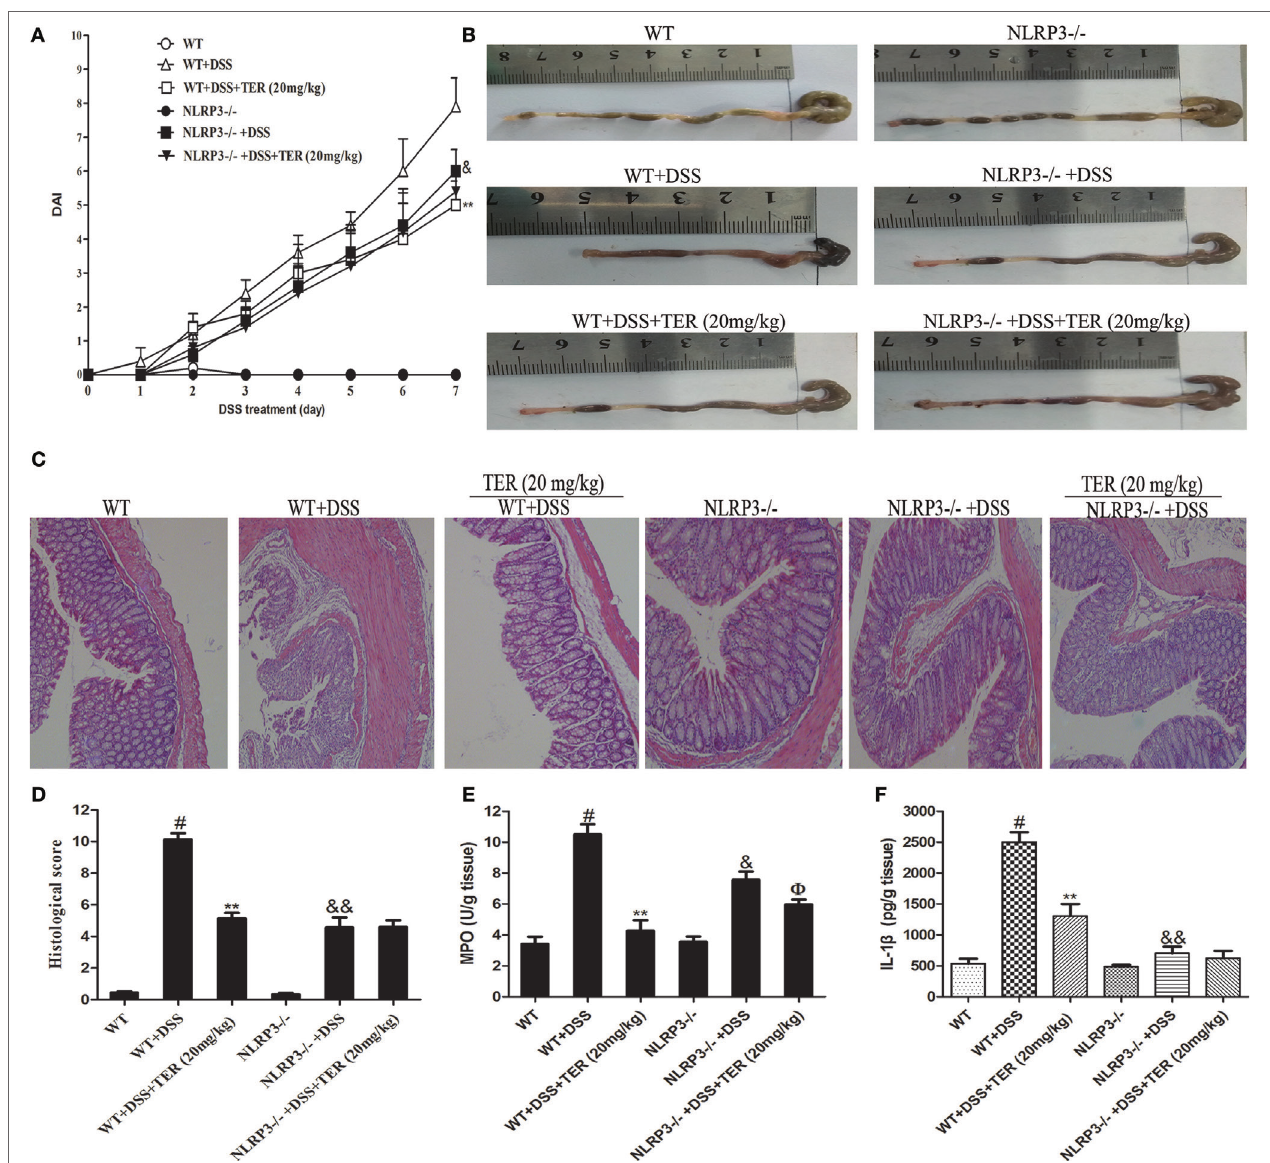
FigUre 4 | nlrP3 deficiency protects mice from dextran sulfate sodium (Dss)-induced acute colitis . Wild-type (WT) and NLRP3 − / − mice were treated with 2.5% DSS in their drinking water for 7 days to induce acute colitis. Twenty milligrams per kilogram terpinen-4-ol (TER) was administered for 14 days before and during DSS treatment via oral gavage once per day. Mice were sacrificed at day 21. (a) Disease activity index (DAI) during the disease process. (B) The lengths of colons from each group of mice were measured. (c) The colons from each experimental group were processed for histological evaluation (hematoxylin–eosin staining, 200 × ; scale bar, 50 µm). (D) Histopathological scores of each group were determined. (e) Myeloperoxidase (MPO) activity in the colon tissues was detected. (F) Protein level of interleukin-1 β in colon tissues was determined by enzyme-linked immunosorbent assay. Data are presented as means ± SD ( n = 4). ** p < 0.01 vs the group treated with only DSS; # p < 0.05 vs the control group. & p < 0.05 and && p < 0.01 NLRP3 − / − vs WT mice in the group treated with only DSS. ɸ p < 0.05 vs DSS-treated NLRP3 − / − mice